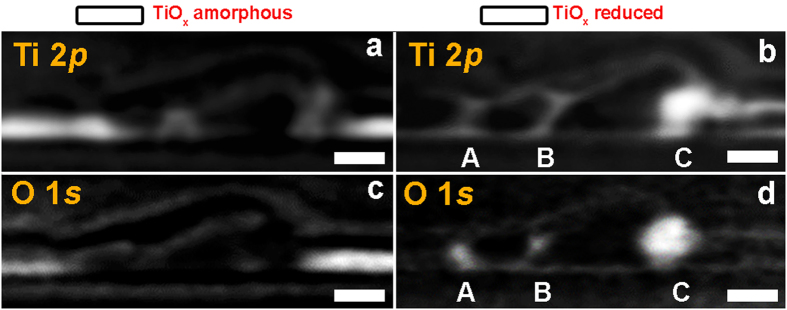
Chemical maps depicting regions of amorphous and reduced TiOx.Components maps at the Ti 2p (a,b) and at the O 1 s (c,d). Scale bar = 100 nm.